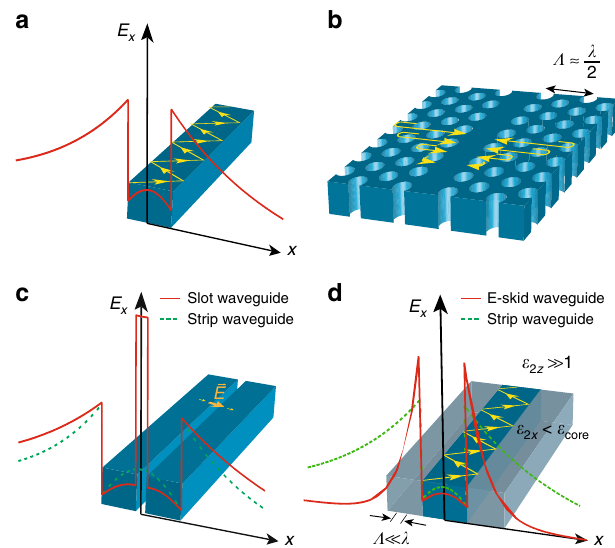
Fig. 1 Fundamental differences between dielectric waveguides on an SOI platform. a Strip waveguide; b photonic crystal waveguide; c slot waveguide; d e-skid waveguide. The skin-depth in the cladding of e-skid waveguide is shorter compared to the other structures due to the strong effective anisotropy of the multilayer cladding. This counterintuitive approach can have a cladding with a higher average index than the core and marks a departure from interference-based con fi nement as in photonic crystal waveguides or slot waveguides which utilize nanoscale fi eld